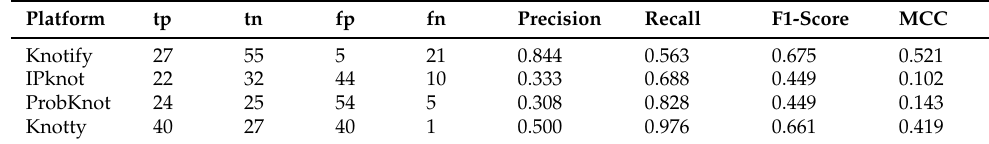
Table 4. Four fundamental metrics per platform.